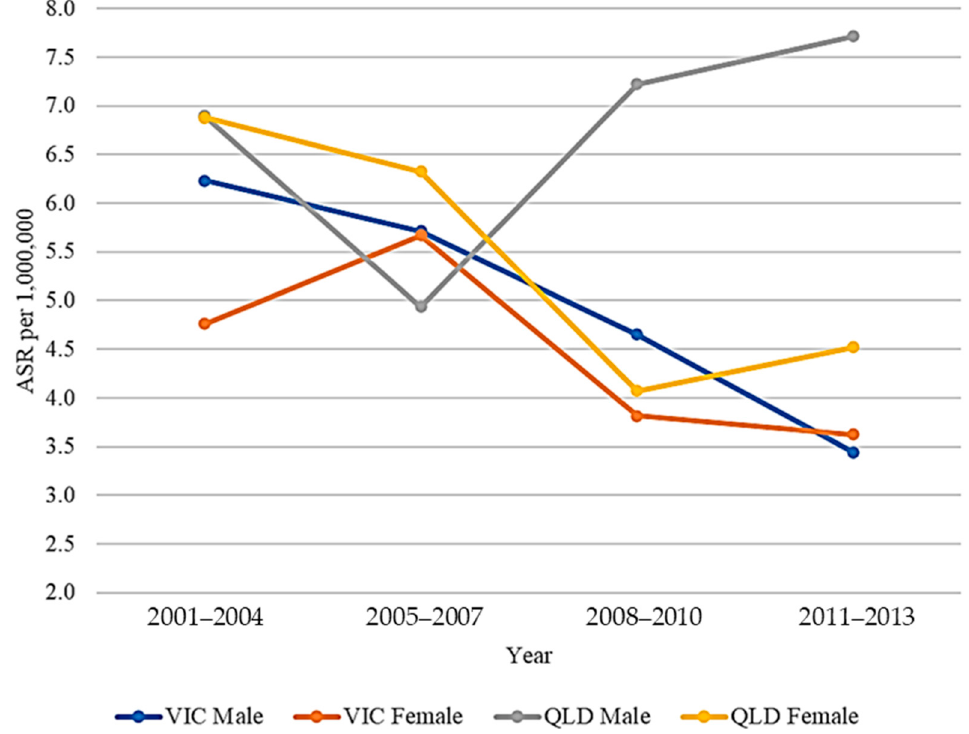
Figure 2. UM mean ASR over time in VIC and QLD from 2001 to 2013. Graph shows mean ASRs only. Bivariate regression of all ASRs against time, controlling for age: QLD male, r = +0.086, p = 0.48; QLD female, r = − 0.215, p = 0.07; VIC male, r = − 0.224, p = 0.06; VIC female, r = − 0.149, p = 0.21. Table 4. UM ASR 1 in QLD and VIC in different ages in 2001–2007 and 2008–2013.